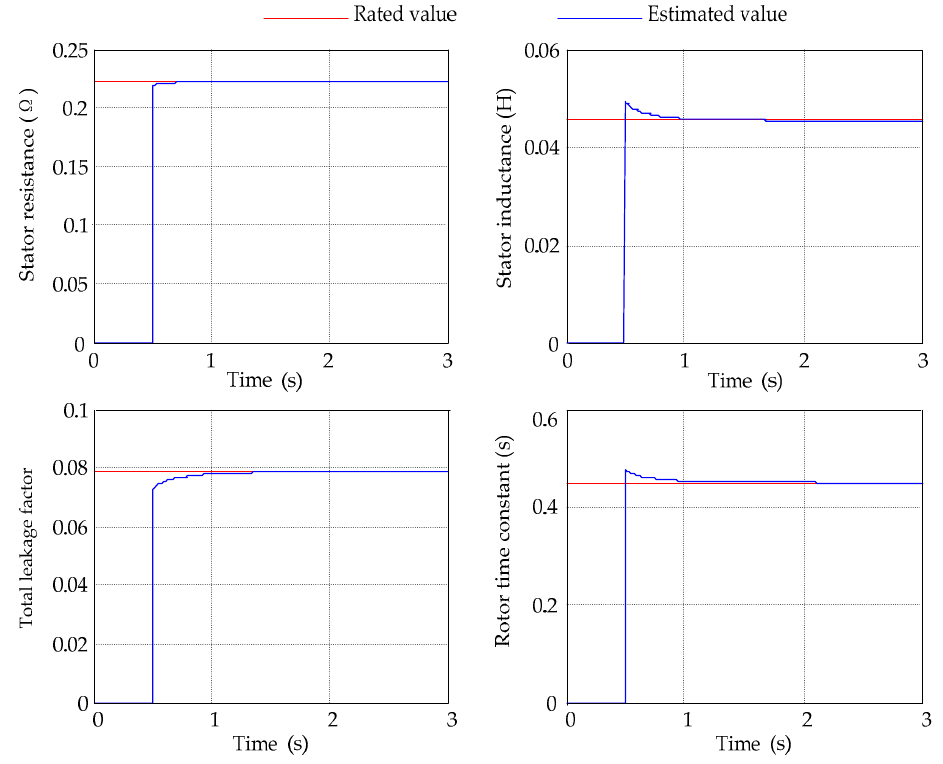
Figure 11. Identification results of the IM using the offline recursive least square method, where the stator inductance L s = L ls + L m , the total leakage factor σ = 1 − L m2 / L s / L r and L r = L lr + L m .